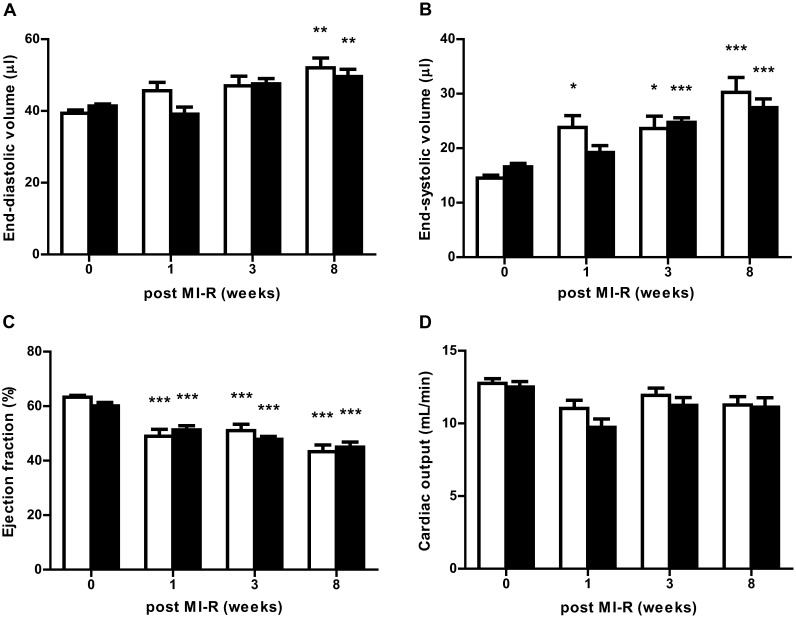
Serial echocardiography.(A) End-diastolic volume, (B) end-systolic volume, (C) ejection fraction, and (D) cardiac output in NC-MI (open bars) and HC-MI (closed bars) groups at baseline, 1, 3, and 8 weeks after MI-R (n = 16–18). Data are means ± SEM. *P<0.05, **P<0.01, ***P<0.001 all vs. week 0.